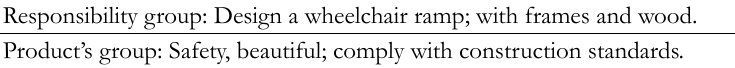
Table 3. Worksheet 1. The results of